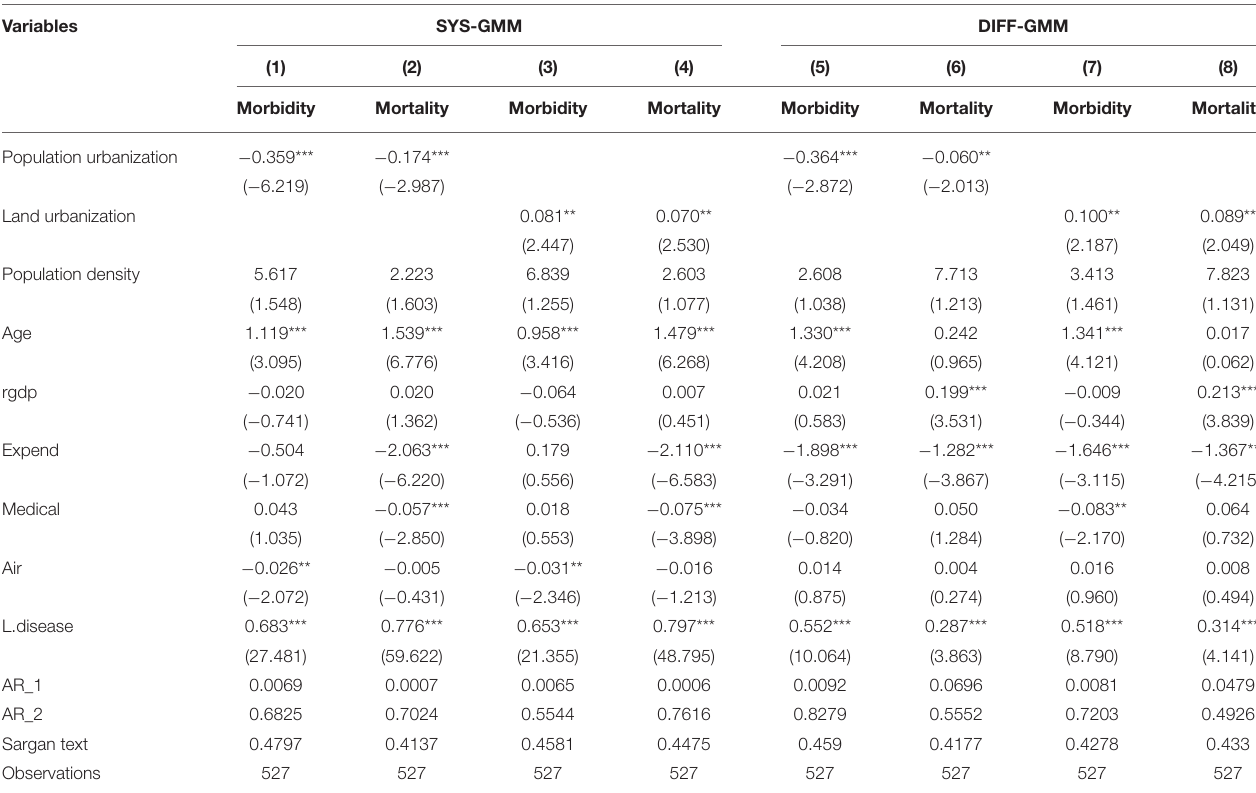
TABLE 2 | Baseline regression results of urbanization on the spread of infectious diseases. Variables